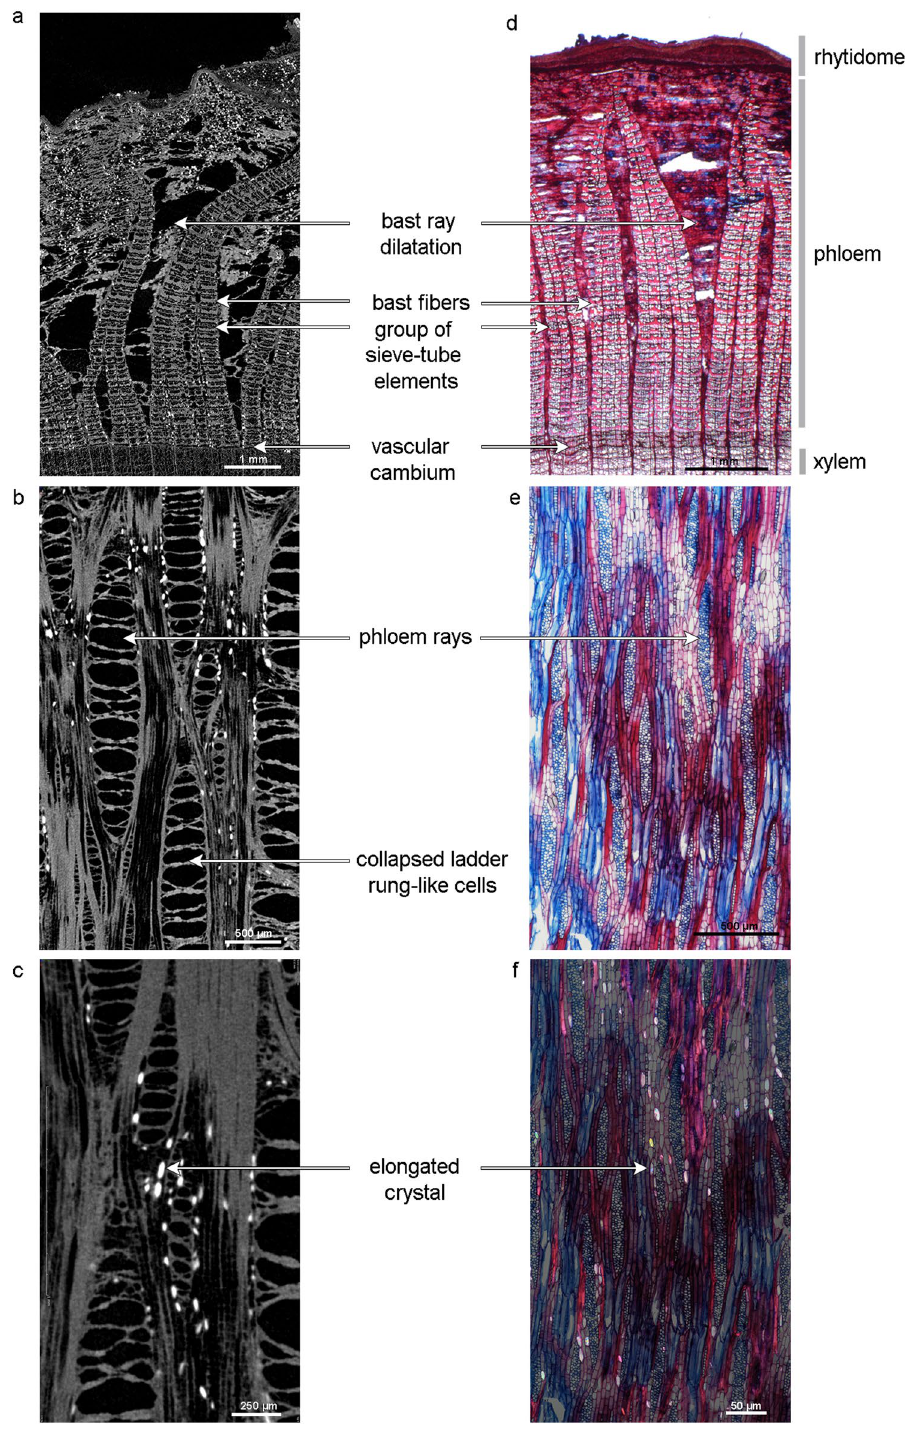
Figure 3. Characteristics of lime (sample 1, Table 1) recorded with µCT (left) and microscopy (right) with transmitted ( d , e ) and polarised ( f ) light of thin sections stained to highlight lignified (red) and non-lignified (blue) cells. ( a ) and ( d ) represent the transversal, and ( b ), ( c ), ( e ), ( f ) the tangential section. The tangential sections in ( b ) and ( c ) show characteristic ladder-like-structures that are build when the bark dries out. In pictures ( e ) and ( f ), on the other hand, the cell structure is still